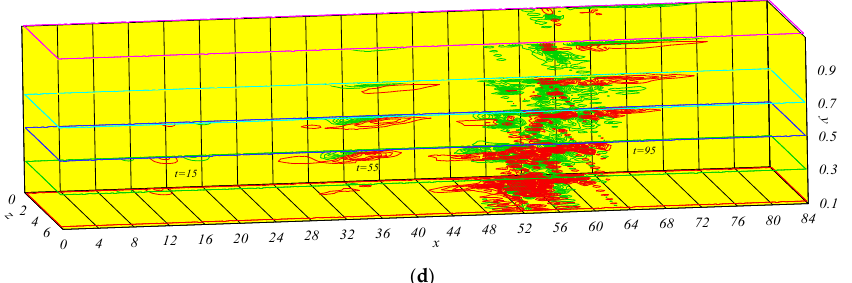
Figure 5. Vectors and contours of vortex structures: ( a ) velocity vectors at t = 15, P–N model; ( b ) velocity vectors at t = 15, N–P model; ( c ) stream-wise high- and low-speed disturbance velocity, contour increment of 0.03, P–N model; ( d ) stream-wise high- and low-speed disturbance velocity, contour increment of 0.03, N–P model.